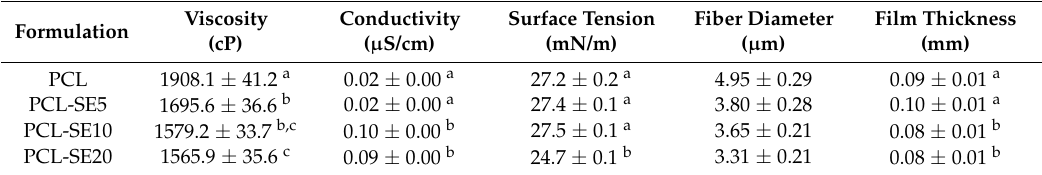
Table 1. Properties of the poly( ε -caprolactone)-based solutions, diameter of the electrospun fibers and thickness of the annealed